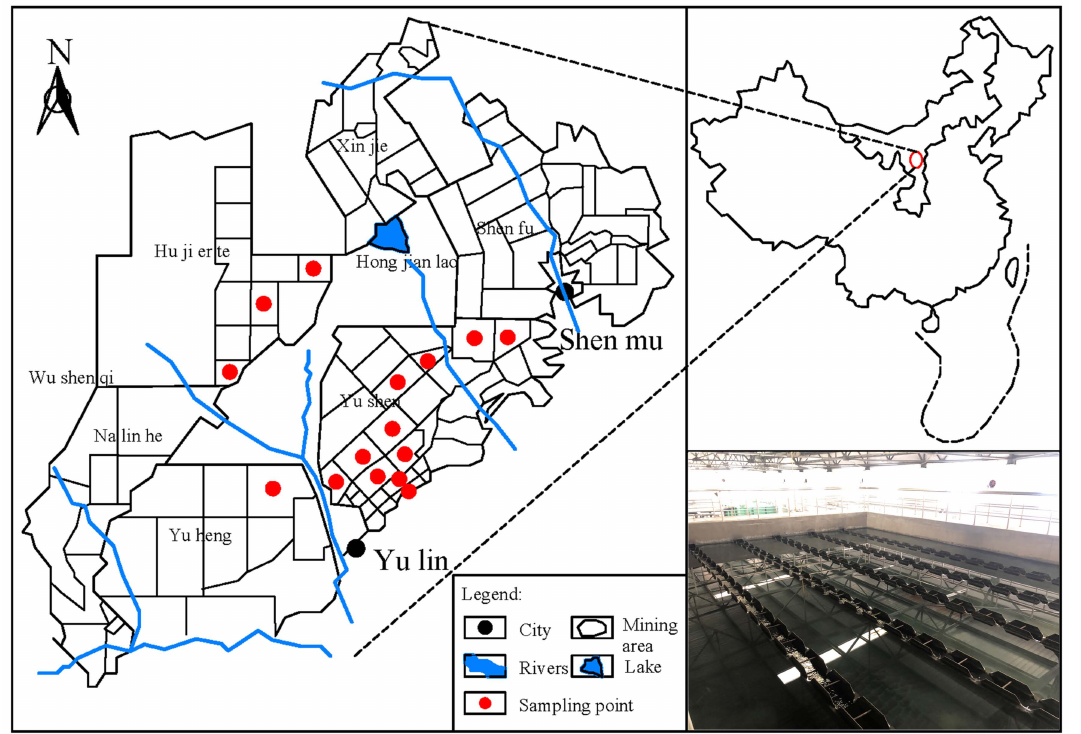
Figure 2. Schematic diagram of sampling